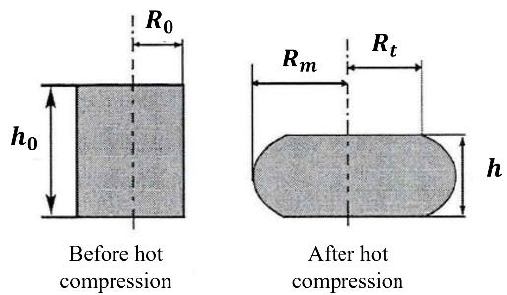
Figure 2. Schematic representation of the changes in the sample before and after hot pressing.